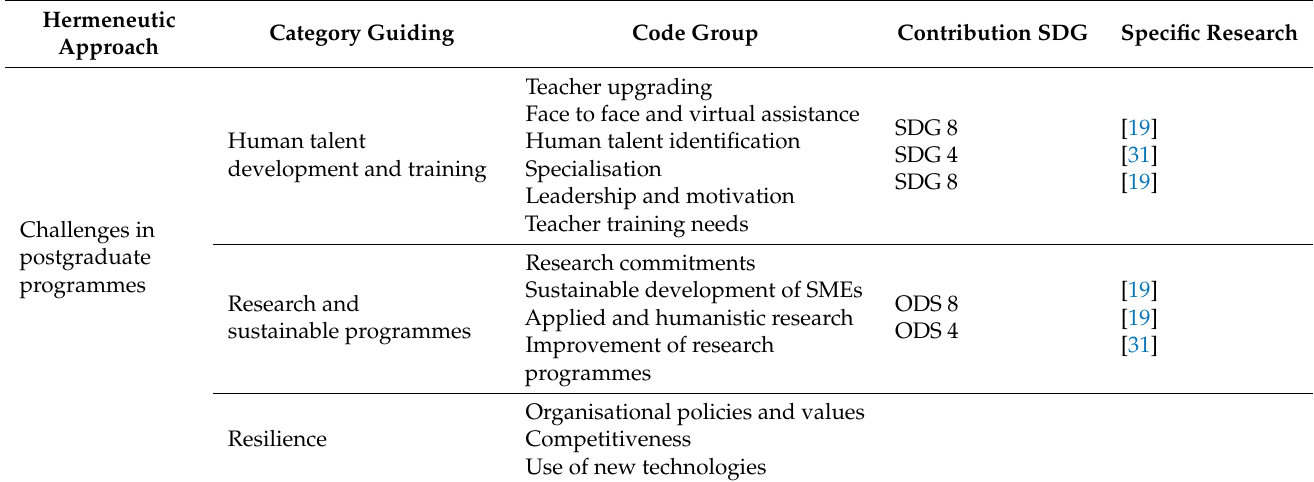
Table 2. Guide to guiding categories, group codes, and their contribution to the SDGs.